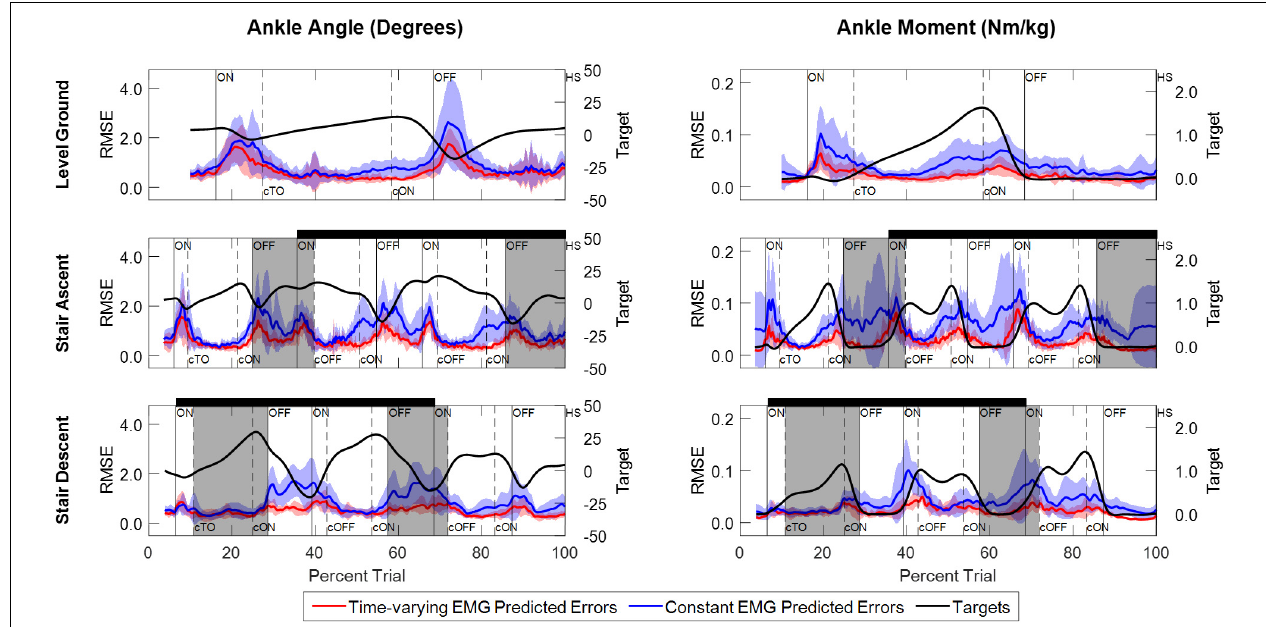
FIGURE 6 | Instantaneous RMSE between experimentally measured values and NARX model predictions of ankle angle and ankle moment across trials and participants. Errors are shown for model predictions using the participant’s time-varying EMG as input (red trace) and for model predictions using the average EMG signal as a constant input (blue trace). Shaded regions denote ± 1 standard deviation. The ankle angle and moment targets averaged across trials and participants are shown for reference (black trace) and scaled accordingly to the right-side vertical axis. Double limb support intervals and gait event markers are defined the same as Figure 3